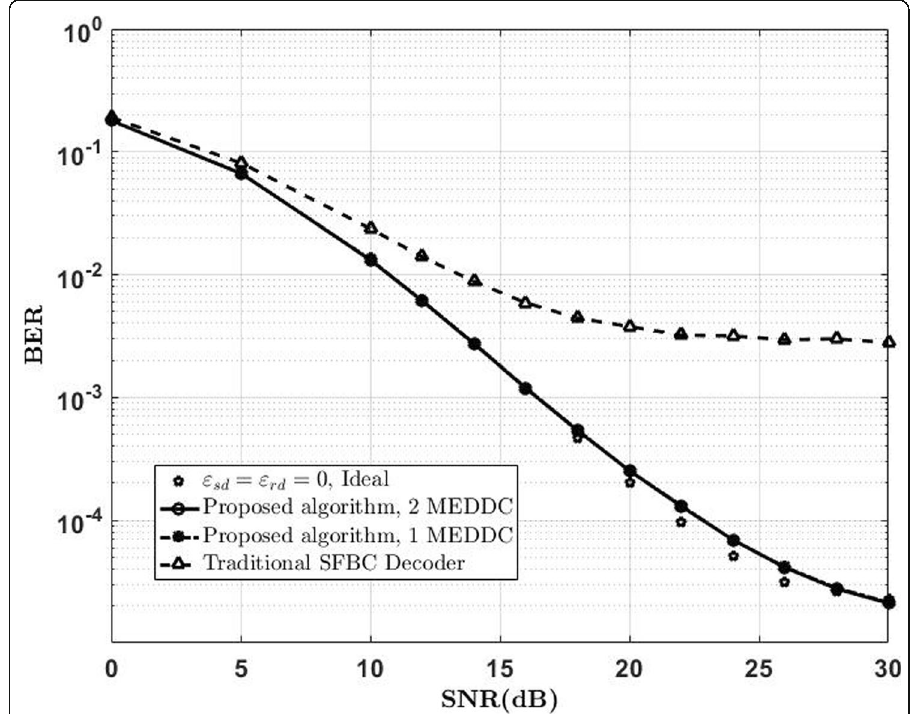
Fig. 6 BER performance of systems without code versus SNR with | ε rd − ε sd | max = 0.2. Figure 6 shows the BER performance of systems without code versus SNR for the proposed MCFO compensation algorithm, and the simulation setup is no frequency offset no compensation. | ε rd − ε sd | max = 0.2, and PB channel was